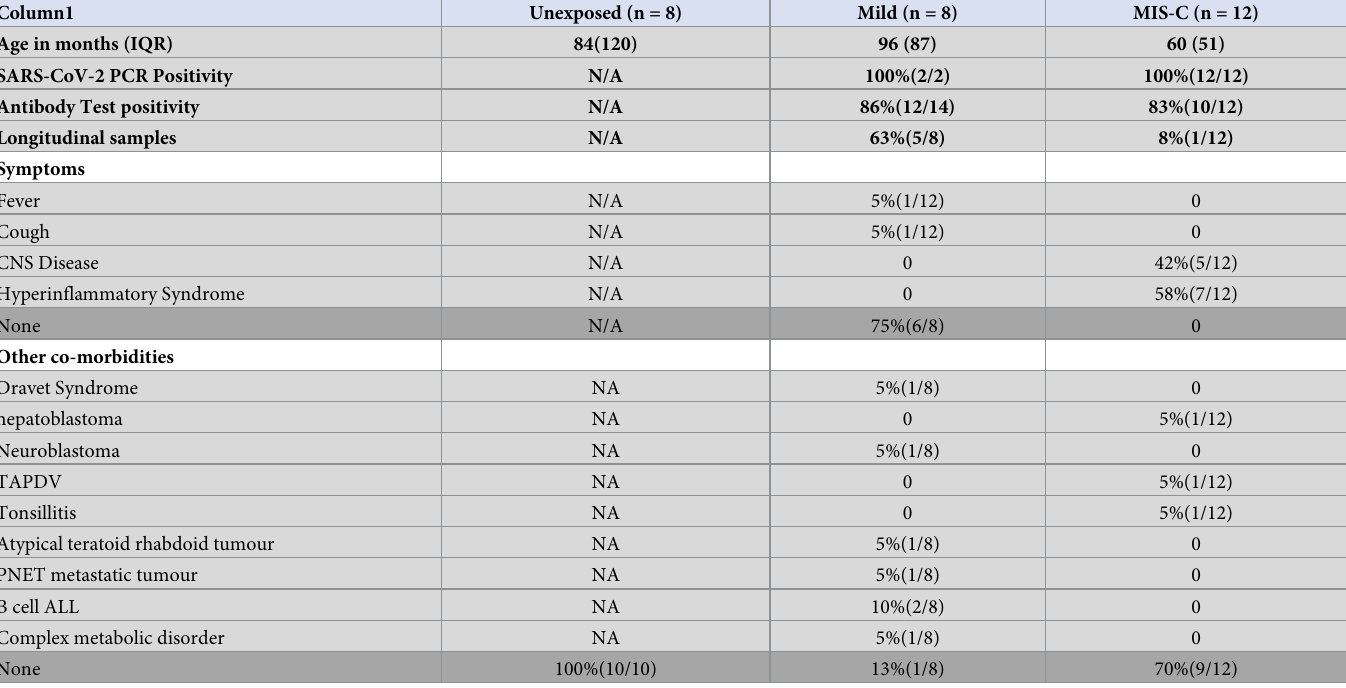
Table 1. Cohort characteristics of SARS-CoV-2 infected children and unexposed children.